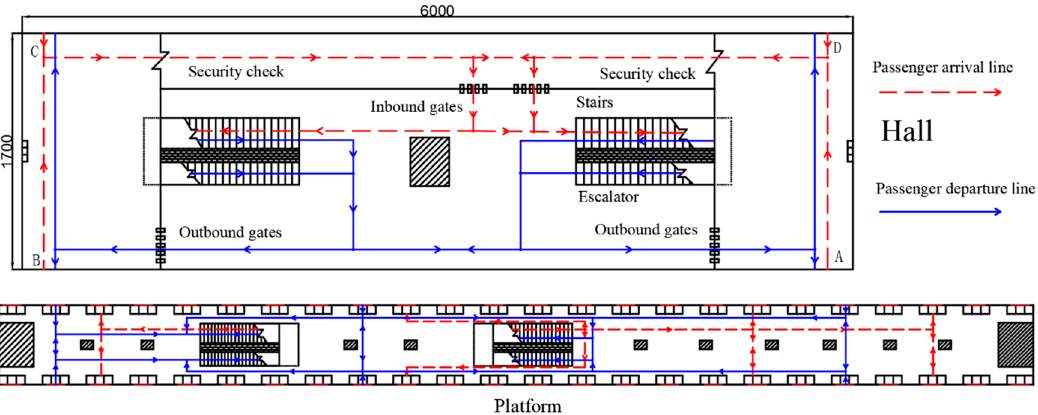
Figure 5. The streamline layout of the subway station.